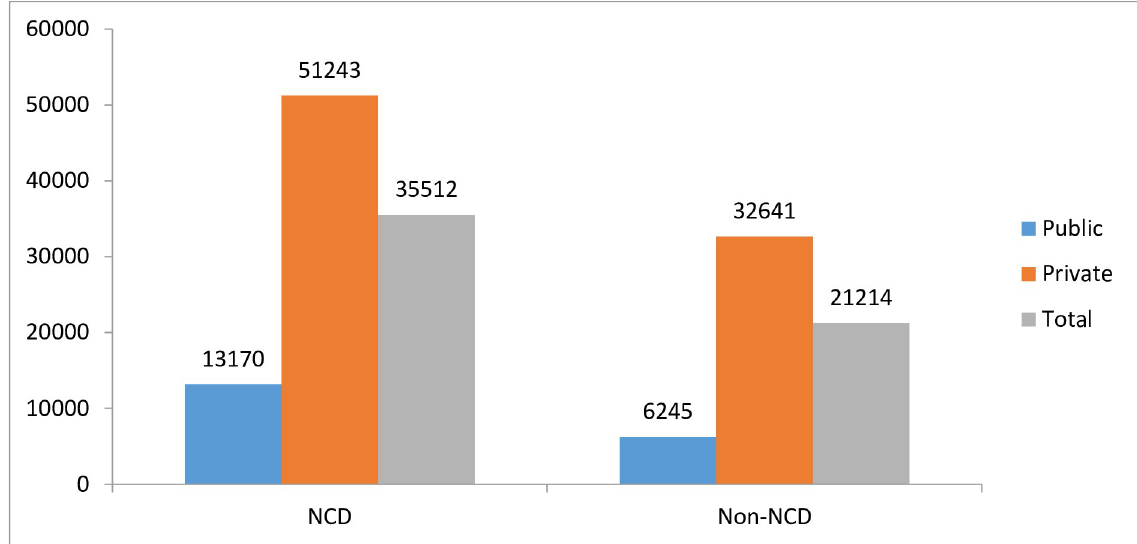
Fig 1. Mean OOPE by type of disease and healthcare facility,